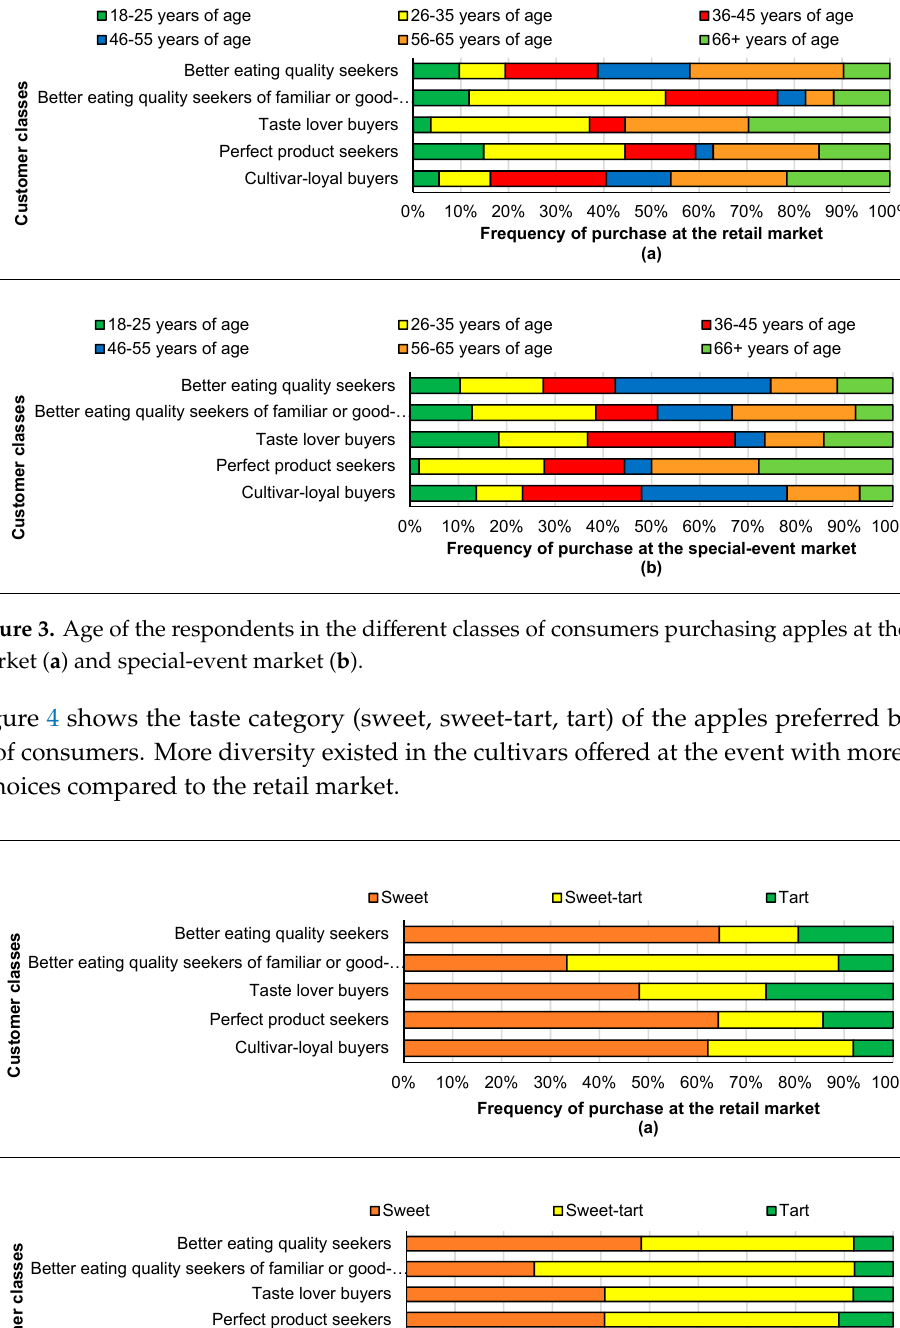
Figure 2. Apple cultivars purchased by five different classes of customers at the retail market ( a ) and special-event market ( b ).